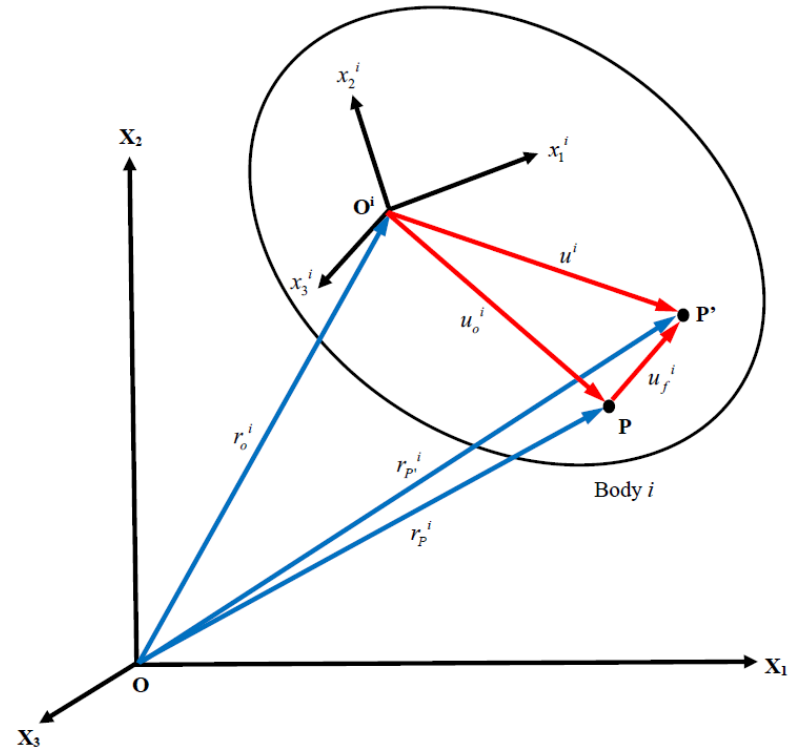
Figure 1. A deformable body i in an Euclidean space.